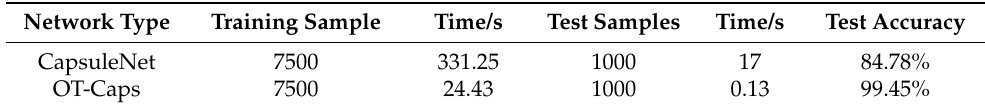
Table 2. Comparison results with the CapsuleNet.